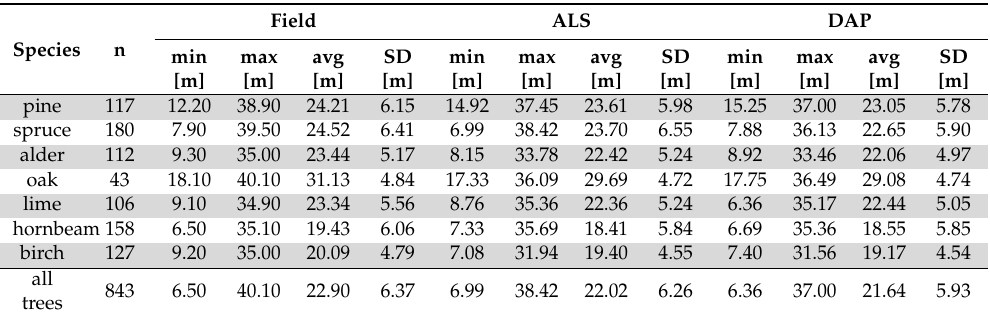
Table 4. Descriptive statistics of tree heights obtained for di ff erent measurement methods.